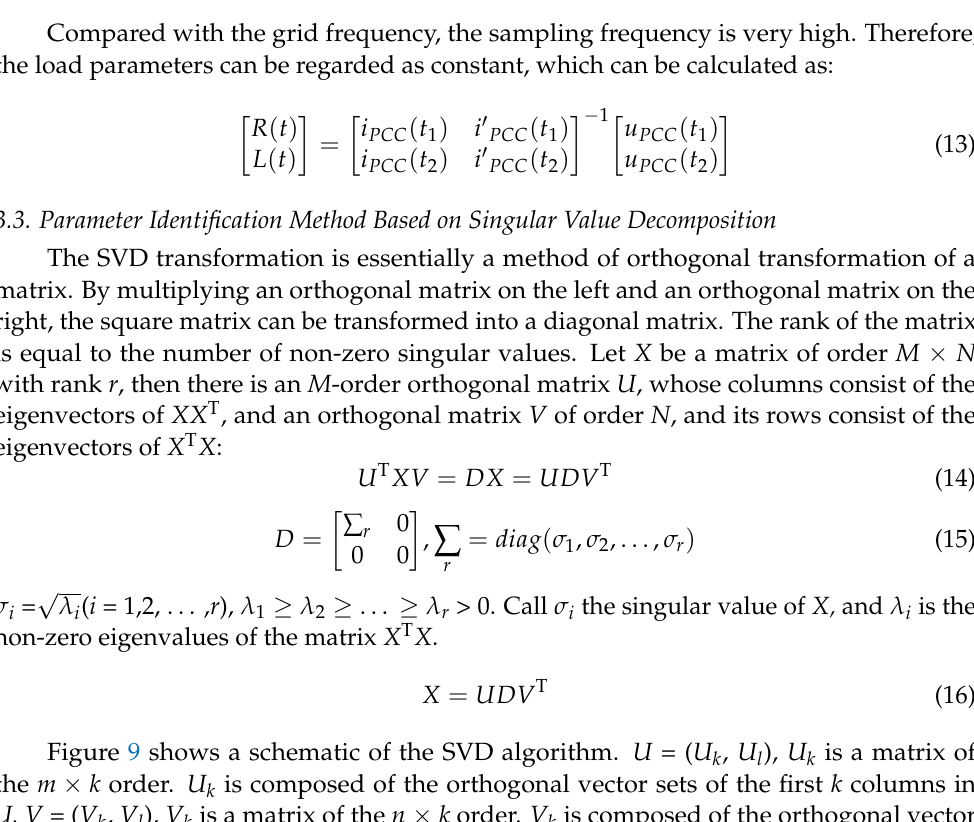
Figure 8. Simplified equivalent circuit model.